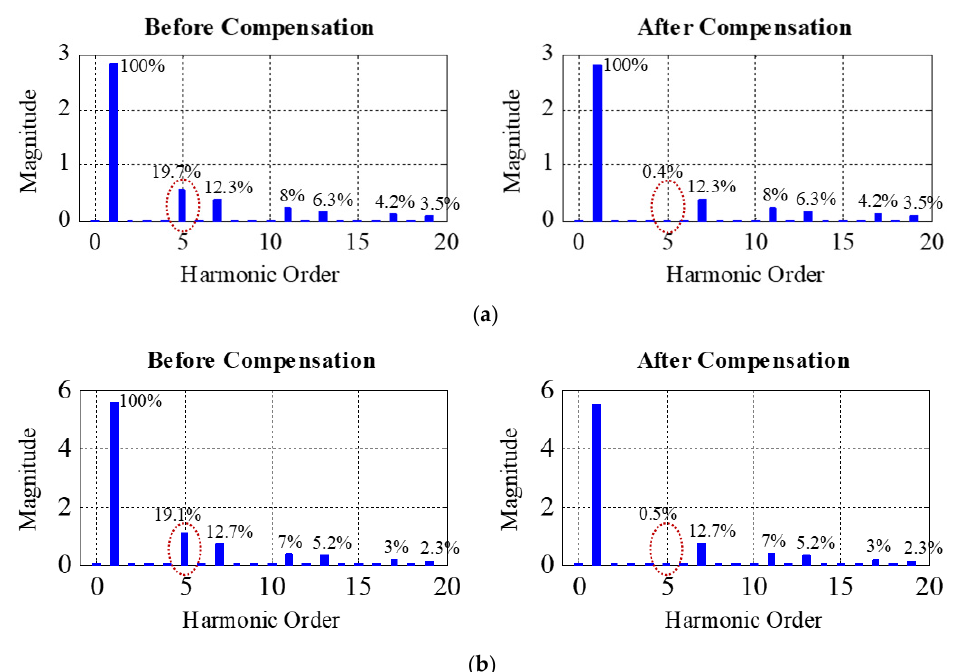
Figure 16. Spectrums of the source current using ADALINE for compensating the harmonic current order 5: ( a ) Spectrums at intervals 0 ≤ Time < 0.25 s; ( b ) Spectrums at intervals 0.25 ≤ Time < 0.5 s. Table 5. The average performance value of ADALINE individual harmonic detection.